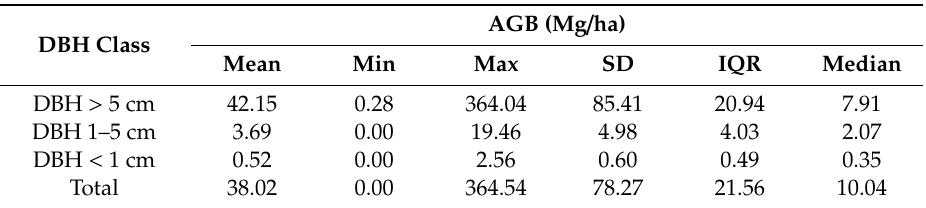
Table 1. Summary of the aboveground biomass (AGB) values based on the field data according to the diameter at breast height (DBH) class (n = 49). AGB was estimated based on diameter at ground level for shrubs with a DBH < 1 cm. SD = standard deviation, IQR = interquartile range.